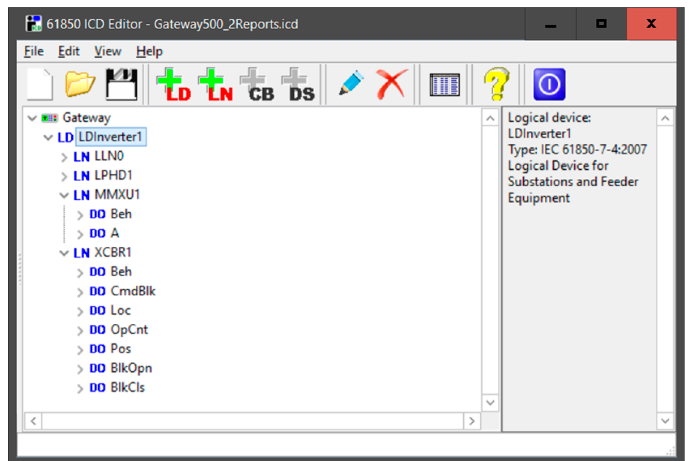
Figure 14. Editing ICD file with 61850 ICD editor.